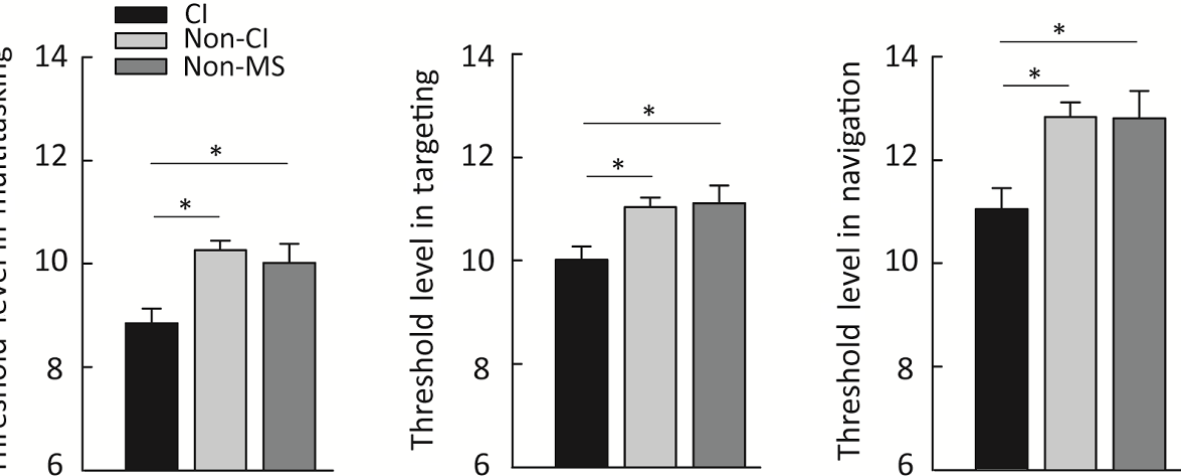
Figure 3. Group differences in EVO Monitor performance between CI, non-CI participants with MS and non-MS participants. Error bars represent